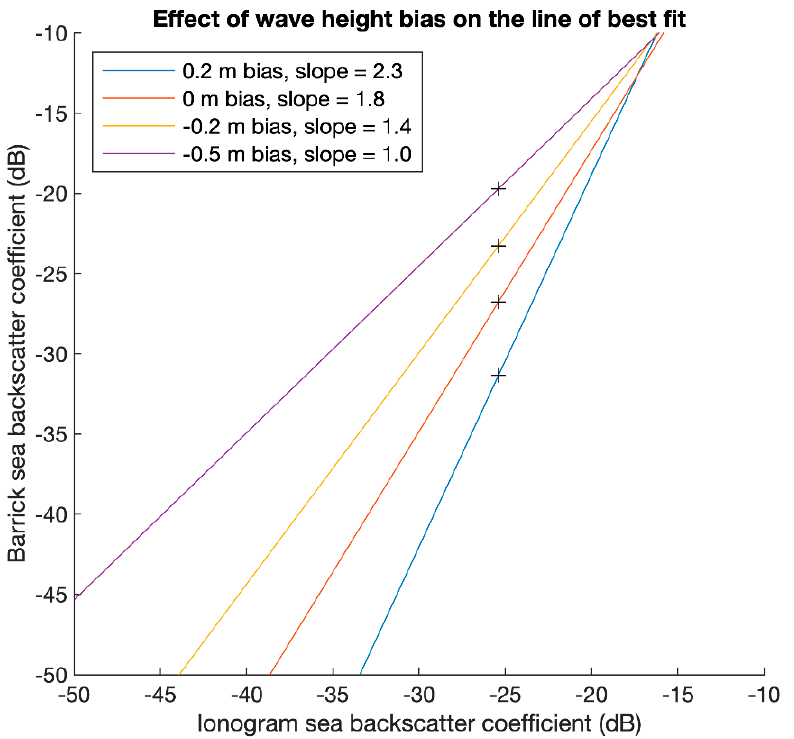
Figure 16. Effect of accounting for various potential wave height biases in the sea state data used for the Barrick method on the line of best fit for the Alice Springs September 2015 Barrick versus the ionogram sea surface backscatter coefficients. The + symbols are at the centre of the error ellipses associated with each line.